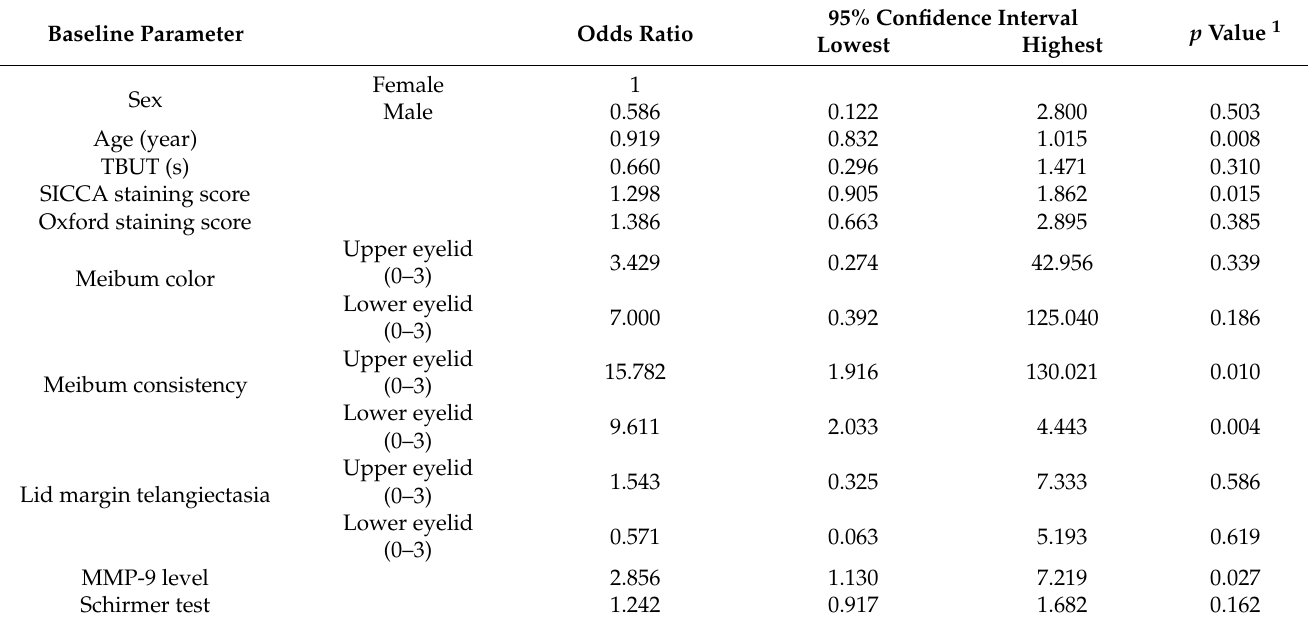
Table 4. Univariate analysis comparing odds ratios of baseline parameters to mean differences of meibomian gland grade in patients with moderate to severe meibomian gland dysfunction.